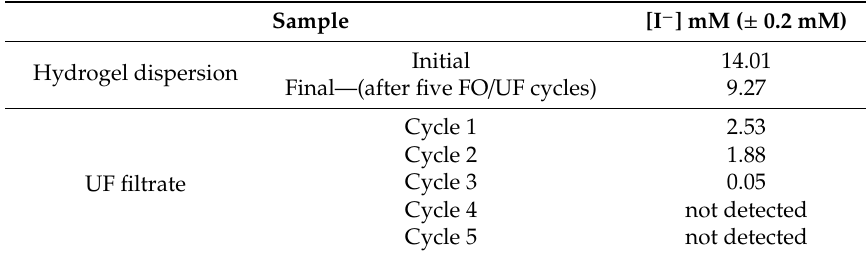
Table 1. Iodide concentration in the ionosilica hydrogel dispersion and UF filtrates along the FO /